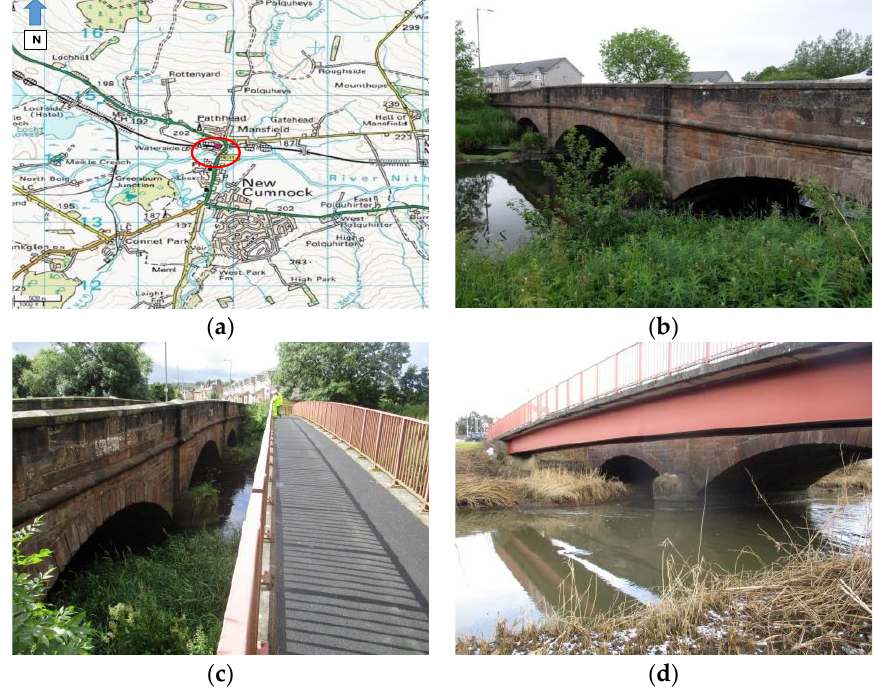
Figure 12. ( a ) Location of the A76 200 Bridge; ( b ) Side view of the A76 200 Bridge; ( c ) The pedestrian bridge; ( d ) Side view of the two bridges. bridge; ( d ) Side view of the two